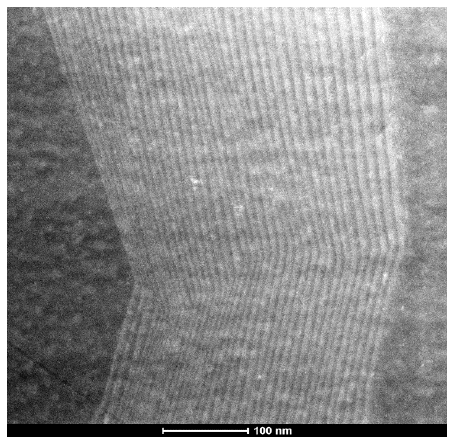
Figure 4. Cross section TEM image of the InAs/InGaAs multilayer QDs.